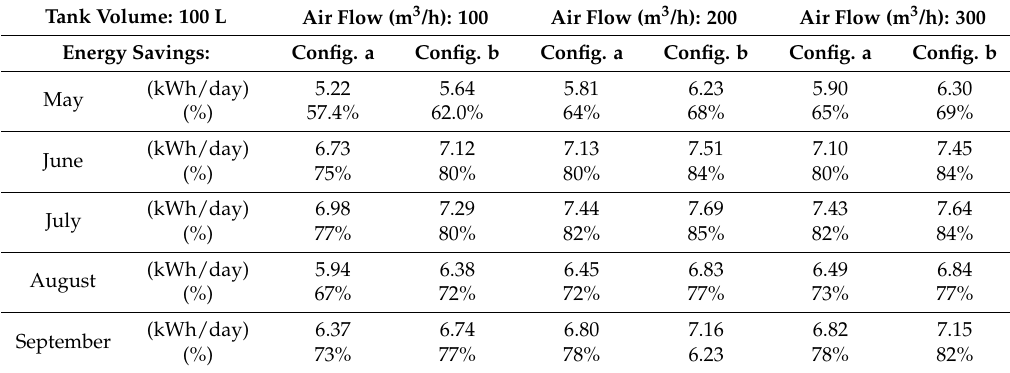
Table 5. Energy savings achievable during typical summer days through both configurations for a water tank of 100